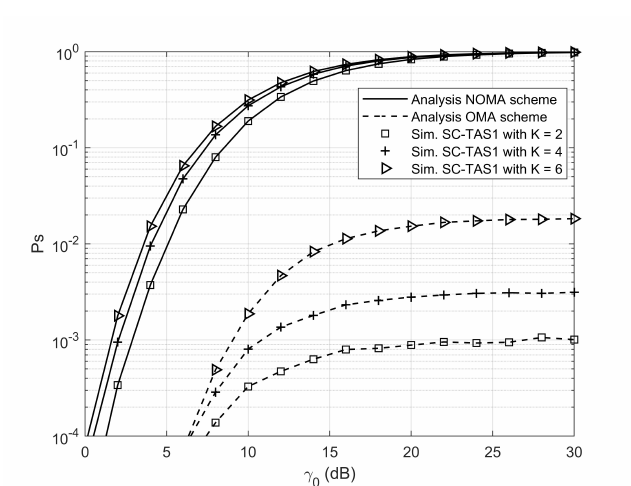
Figure 3. Impacts of the number of antennas K on Ps of SC-TAS1 scheme